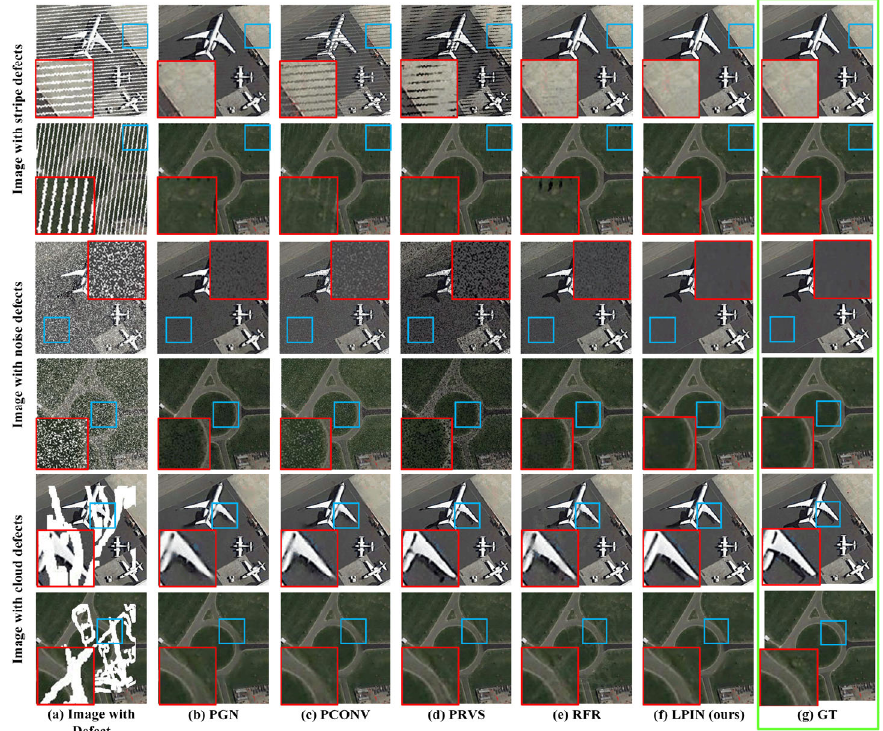
Figure 11. Qualitative visual comparison of inpainting results. ( a ) Images with defects. ( b ) The inpainting results of PGN. ( c ) The inpainting results of PCONV. ( d ) The inpainting results of PRVS. ( e ) The inpainting results of RFR. ( f ) he inpainting results of the proposed LPIN. ( g ) The corresponding GT